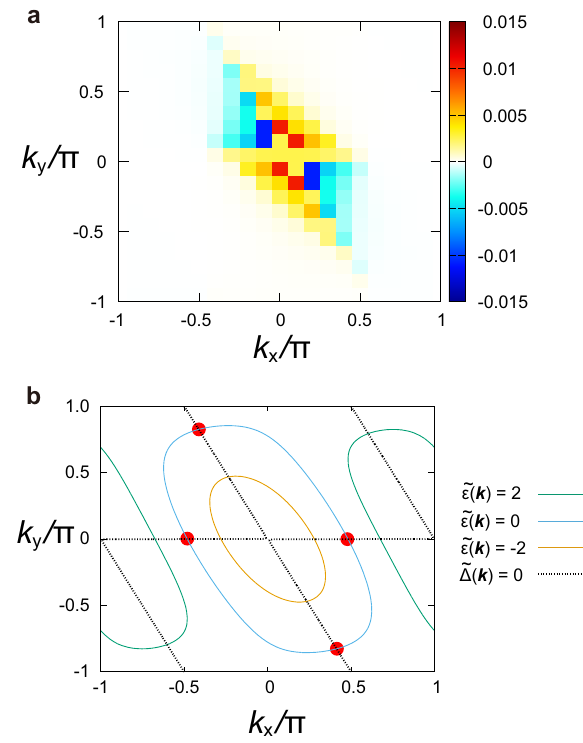
Fig. 8 Dispersion of excitation inferred from the optimized variational wavefunction. The optimized f ( k ) shown in ( a ) are fi tted by ~ ϵ ð k Þ and ~ Δ ð k Þ in the form Eq. (20) shown in ( b ). The intersections of the variational “ Fermi line ” ~ ϵ ð k Þ ¼ 0 (blue curve) and the vanishing gap line ~ Δ ð k Þ ¼ 0 (dotted black lines), indicated by the red circles are the estimated gapless nodal